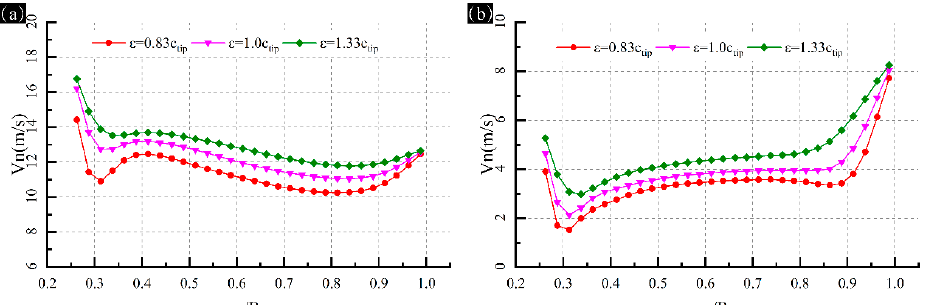
Figure 10. The V n and V t of each blade element along the blade when rotating speed is ( a ) 400 RPM, Figure 10. The V (cid:2924) and V (cid:2930) of each blade element along the blade when rotating speed is ( a ) 400 RPM, Figure 10. The V (cid:2924) and V (cid:2930) of each blade element along the blade when rotating speed is ( a ) 400 RPM, ( b ) 550 RPM. ( b ) 550 RPM. ( b ) 550 RPM. Figure 10. The V (cid:2924) and V (cid:2930) of each blade element along the blade when rotating speed is ( a ) 400 RPM, ( b ) 550 RPM.